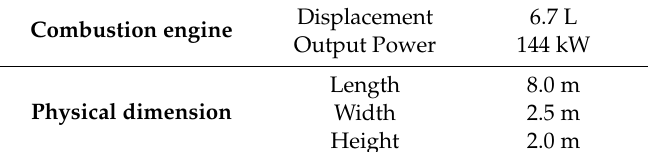
Table 2. Specifications of the LHD.